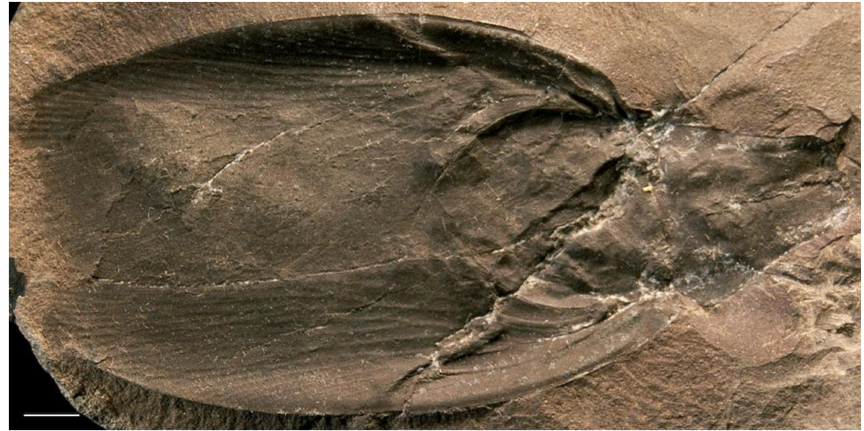
Figure 4. Type specimen of Archoblattina beecheri (Sellards, 1903), regarded here as a nomen dubium and Progonoblattina sp. indet.; Mazon Creek; YPM IP 008412; estimated forewing length 63 mm; scale bar 5 mm; photo: